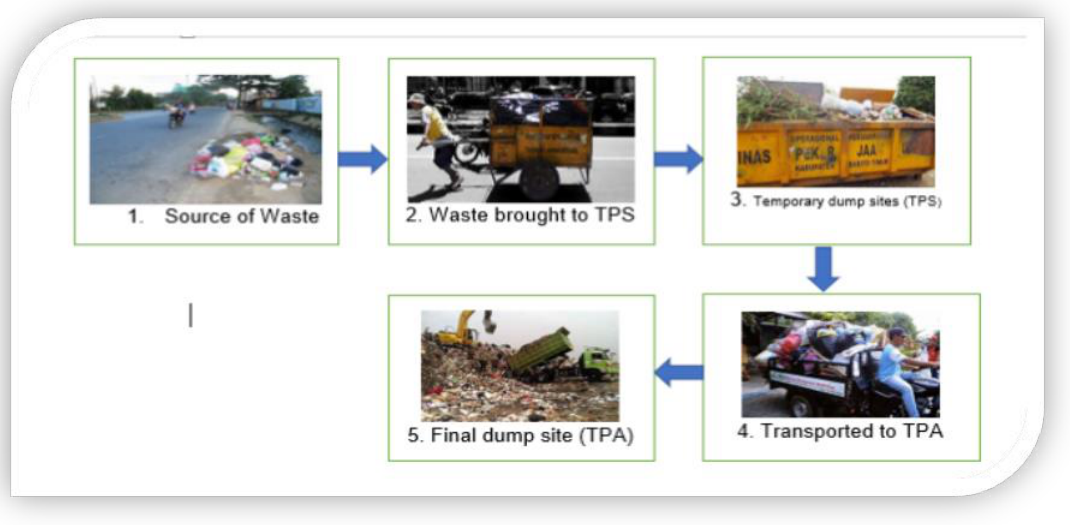
Figure 1: The Current System of waste management in